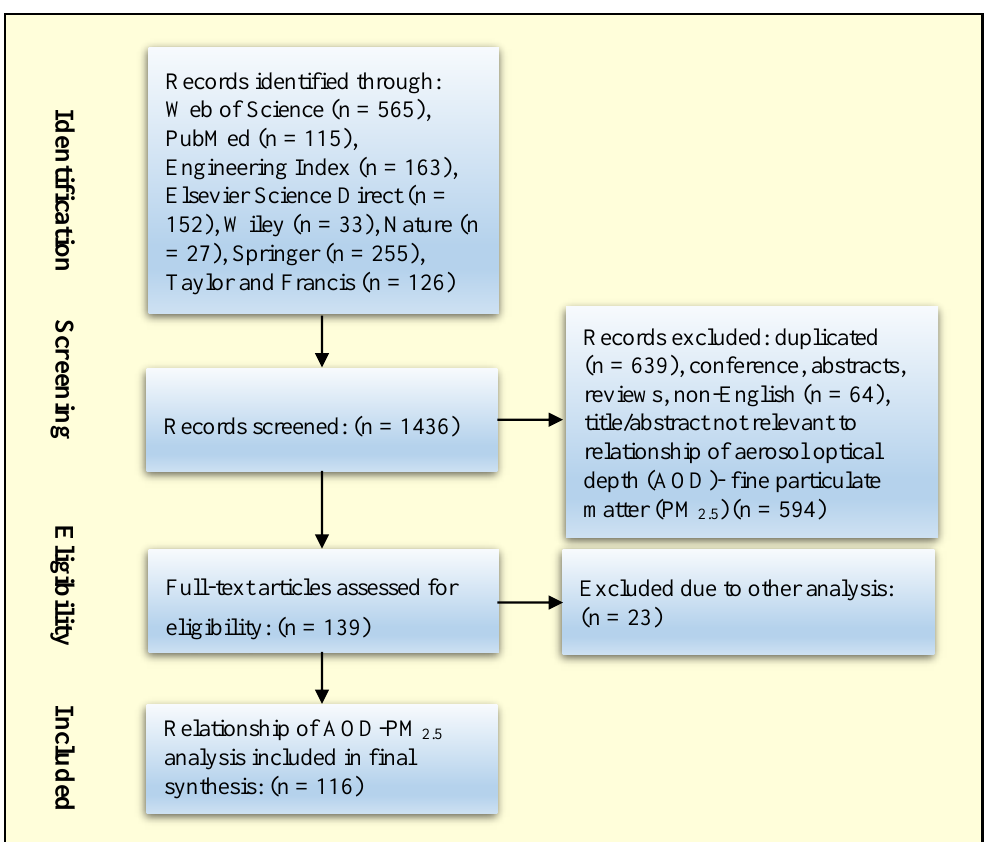
Figure 1. Flow chart of study selection.